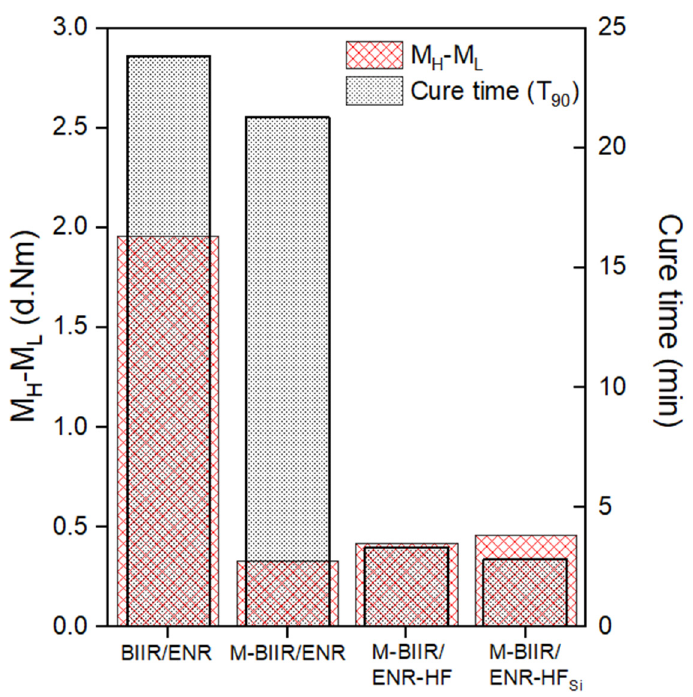
Figure 1. Received of T 90 and M H − M L of unmodified BIIR and M-BIIR/ENR composites filled with CNT/CB with and without the addition of TESPT.